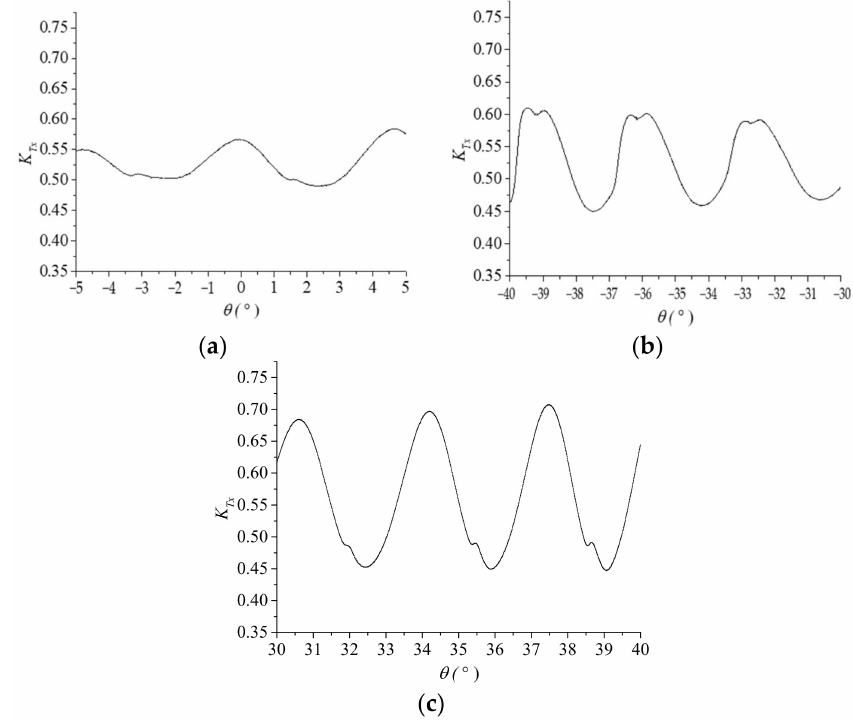
Figure 16. Partial image of Figure 14a: ( a ) − 5 ◦ to 5 ◦ ; ( b ) − 40 ◦ to − 30 ◦ ; ( c ) 30 ◦ to 40 ◦ .